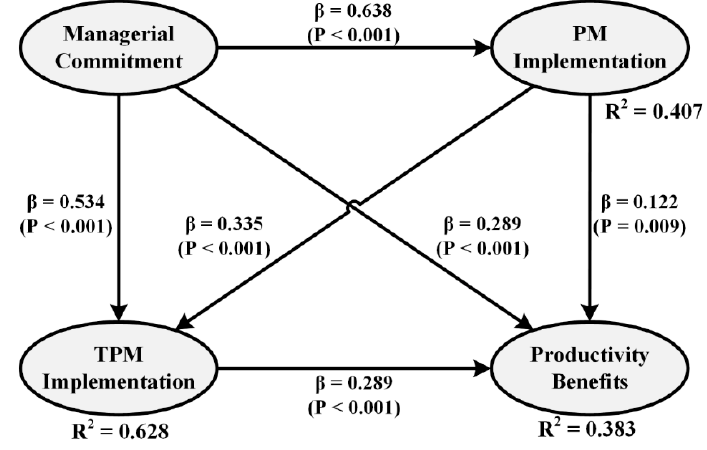
Figure 2. Evaluated model.